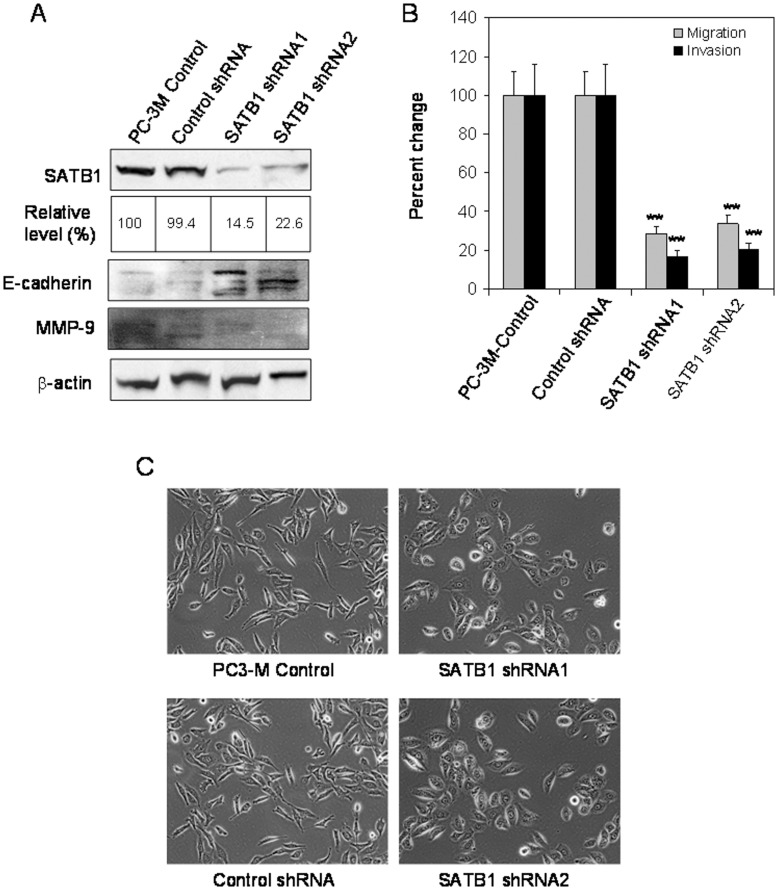
Effect of suppression of SATB1 expression by small hairpin RNA (shRNA) in prostate cancer PC-3M cells.Prostate cancer PC-3M cells were transfected with and without DNA (mock), or the SATB1-targeted shRNA vector 1and 2 and continued in culture for 24 h. (A) SATB1, E-cadherin, MMP9 and <beta>-actin total protein expressions were analyzed by Western blotting. (B) SATB1 silencing in PC-3M cells was associated with low invasive and migration potential. Bars represents the mean±SE of three different assays. **P<0.001 versus control. (C) Representative PC-3M cells images are shown with and without SATB1 shRNA transfection. Details are described in ‘materials and methods’ section.